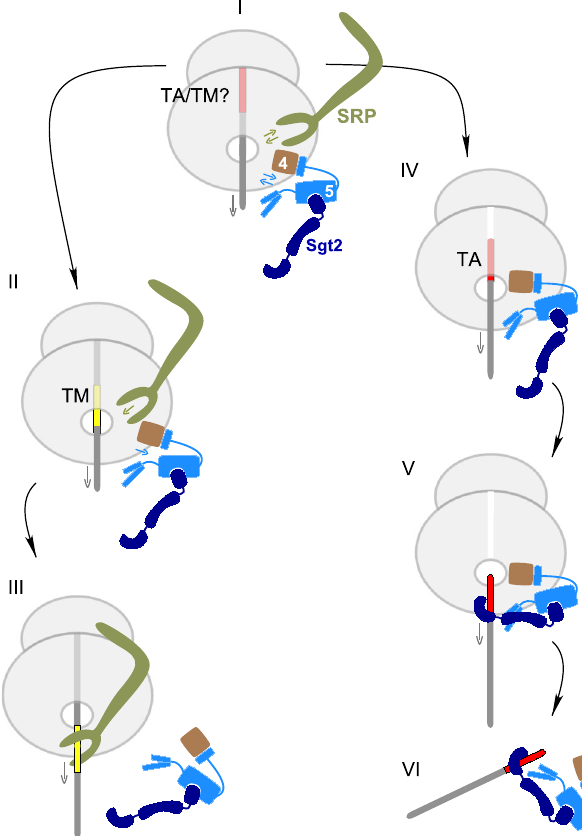
Fig. 7 Model of TM domain capture upon exit from the ribosomal tunnel. (I) A sequence with the characteristics of a hydrophobic α -helical transmembrane domain emerges from the peptidyl transferase center and enters the ribosomal tunnel. At that point, SRP and Get4/5 cycle on and off ribosomes, as it remains unclear if the hydrophobic sequence is a TM domain (internal transmembrane domain) or a TA sequence (C-terminal transmembrane domain). (II) In case translation continues, the hydrophobic sequence remains ribosome-bound as part of the nascent chain and becomes an internal TM domain. (III) Upon exit from the tunnel, the internal TM domain is recognized by SRP. As SRP now binds with high af fi nity, the binding and release cycle of Get4/5, and concurrently Sgt2, is interrupted. (IV) If translation termination occurs immediately after synthesis of the hydrophobic domain, which is then termed TA sequence, SRP is not ef fi ciently recruited to the now non-translating ribosome or the released TA sequence. (V) In this case, Get4/5, and via Get4/5 also Sgt2, continue to sample ribosomes and Sgt2 can capture the TA sequence directly upon arrival at the tunnel exit. Ribosome (light gray), nascent chain (dark gray) TA sequence (red), TM domain (yellow), Get4 (brown) Get5 (light blue), Sgt2 (dark blue), SRP (green). TA (C-terminal tail-anchor sequence) and TM (internal transmembrane